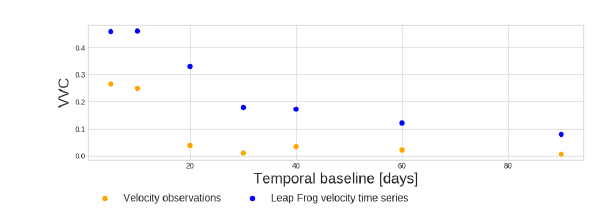
Figure 8. Comparison of VVC over fast moving ice for different temporal samplings. VVC is computed on glaciers areas according to the Randolph Glacier Inventory V6.0 where the mean velocity magnitude observation is higher than 400